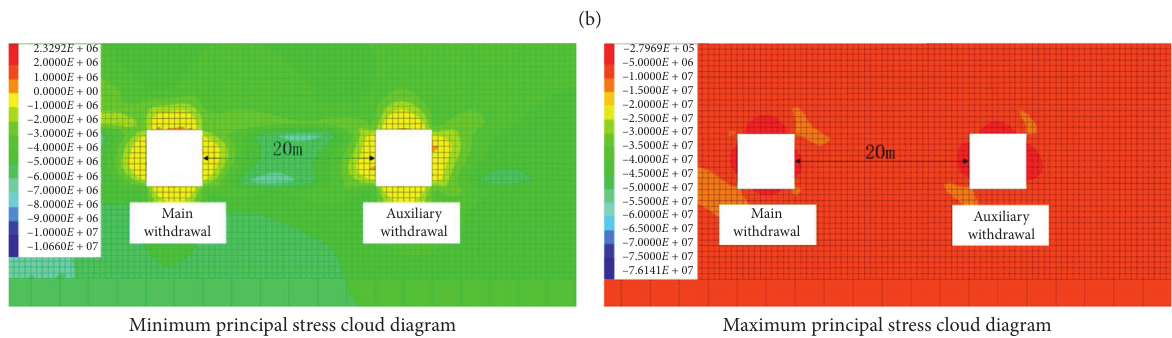
Figure 11: Principal stress cloud diagrams when Panel 31113 distance was 20m from penetration. (a) When the main and auxiliary withdrawal spacing is 30m, (b) when the main and auxiliary withdrawal spacing is 25 m, and (c) when the main and auxiliary withdrawal spacing is